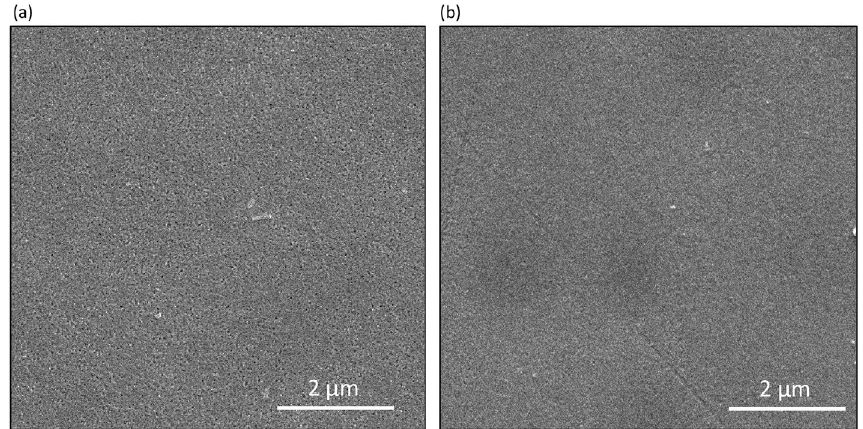
Figure 9. SEM images for (a) PS/pTAP (50%/50%) composite membrane, and (b) PS/pTAP (40%/60%) composite membrane.